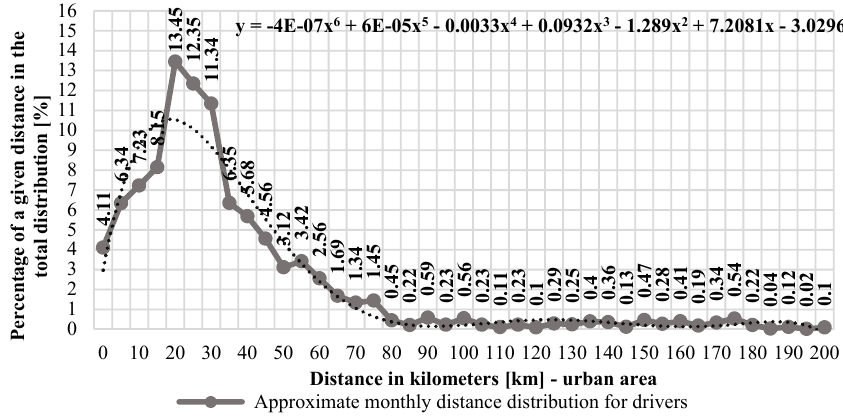
Figure 1. Daily distance distribution for ICEVs, PHEVs, and BEVs operating in urban mode— approximate value based on experimental studies.